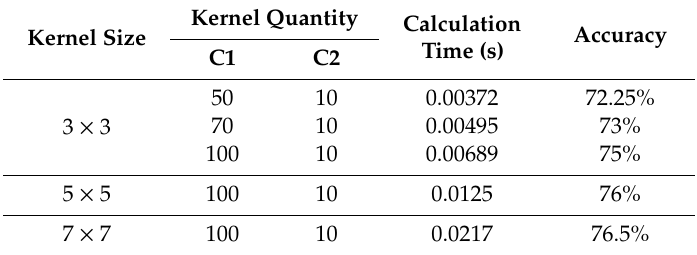
Table 1. Experimental results of different CNN network structures.